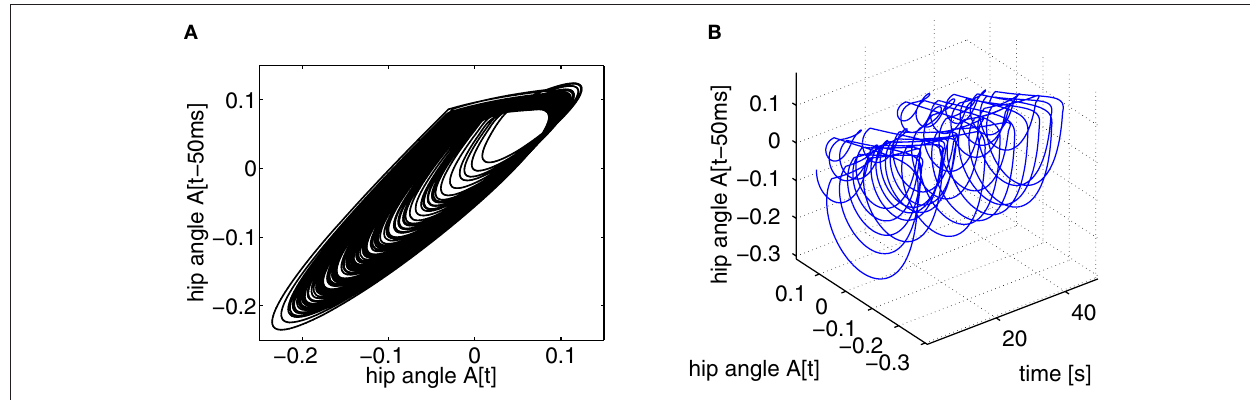
FIGURE 6 | Phase plot of the biped hip angle’s amplitude variation during locomotion (A) and its evolution over time (B); the time delay is set to 50 ms with a sampling time of 5 ms. The hip torques trajectory follows the intrinsic attractor in which the biped belongs. Its dynamics converge sometimes to it and sometimes slightly diverge from